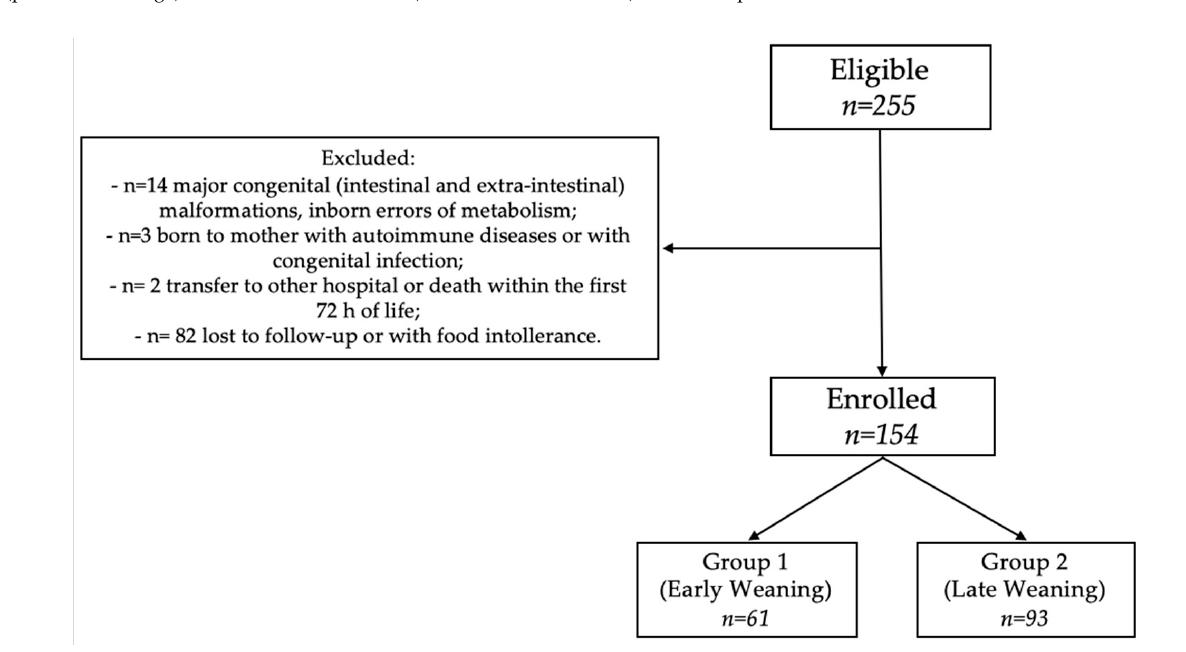
Figure 1. Flow-chart. Table 1. Baseline clinical characteristics of the study population. Table 2. Morbidity rate of the study